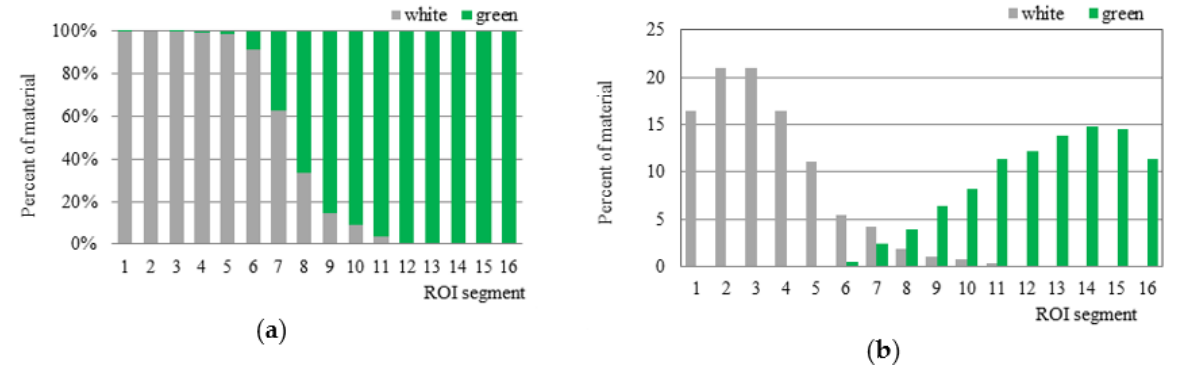
Figure 9. Results after 5 min. of tribocharging and separation: ( a ) percentage of PET and PE-HD in each ROI segments; ( b ) percentage of PET and PE-HD in relation to the surface of the ROI segments.